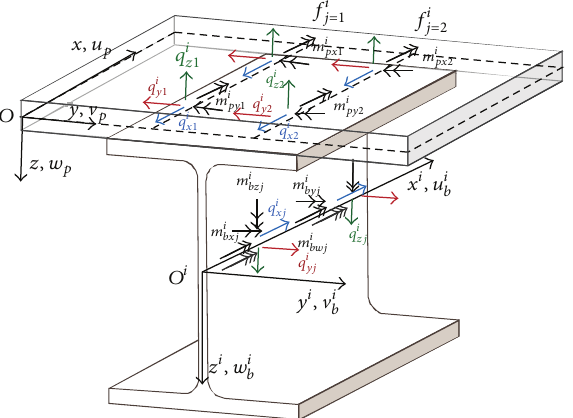
Figure 3: Structural model and directions of the additional loading of the plate and the 𝑖 th